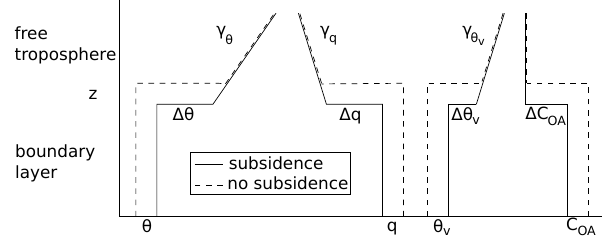
Fig. 10. Sketches of the vertical profiles of θ , q , θ v and C OA at the end of the day (18:50), in cases of subsidence and no subsidence. A 1 indicates the jump of a scalar or reactant C defined as 1C = C FT −h C i and a γ C the lapse rate of a scalar C in the FT.